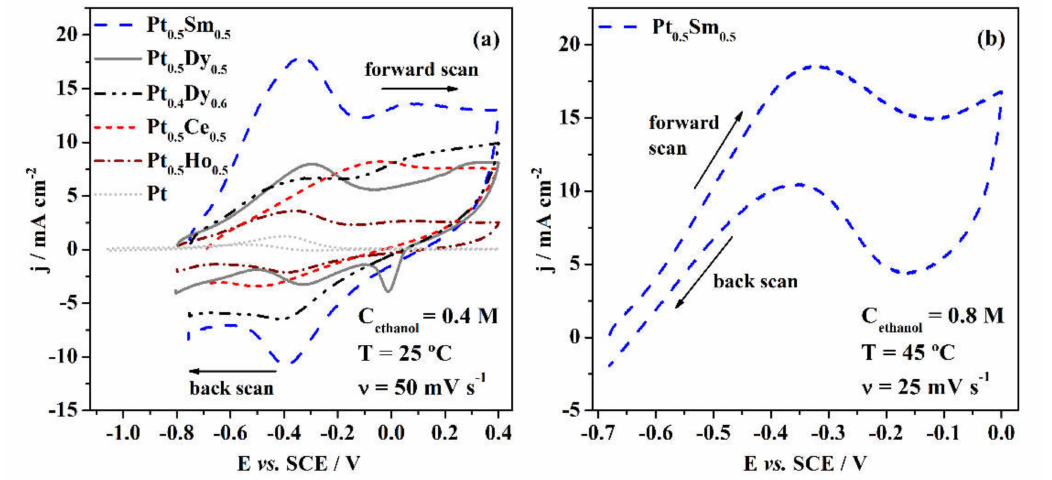
Figure 3. Cyclic voltammograms (CV) of ( a ) Pt and Pt-RE alloys in 0.4 M ethanol + 2 M NaOH at 50 mV s − 1 and 25 ◦ C and shorter-range CV of ( b ) Pt 0.5 Sm 0.5 electrode in 0.8 M ethanol + 2 M NaOH at 25 mV s − 1 and 45 ◦